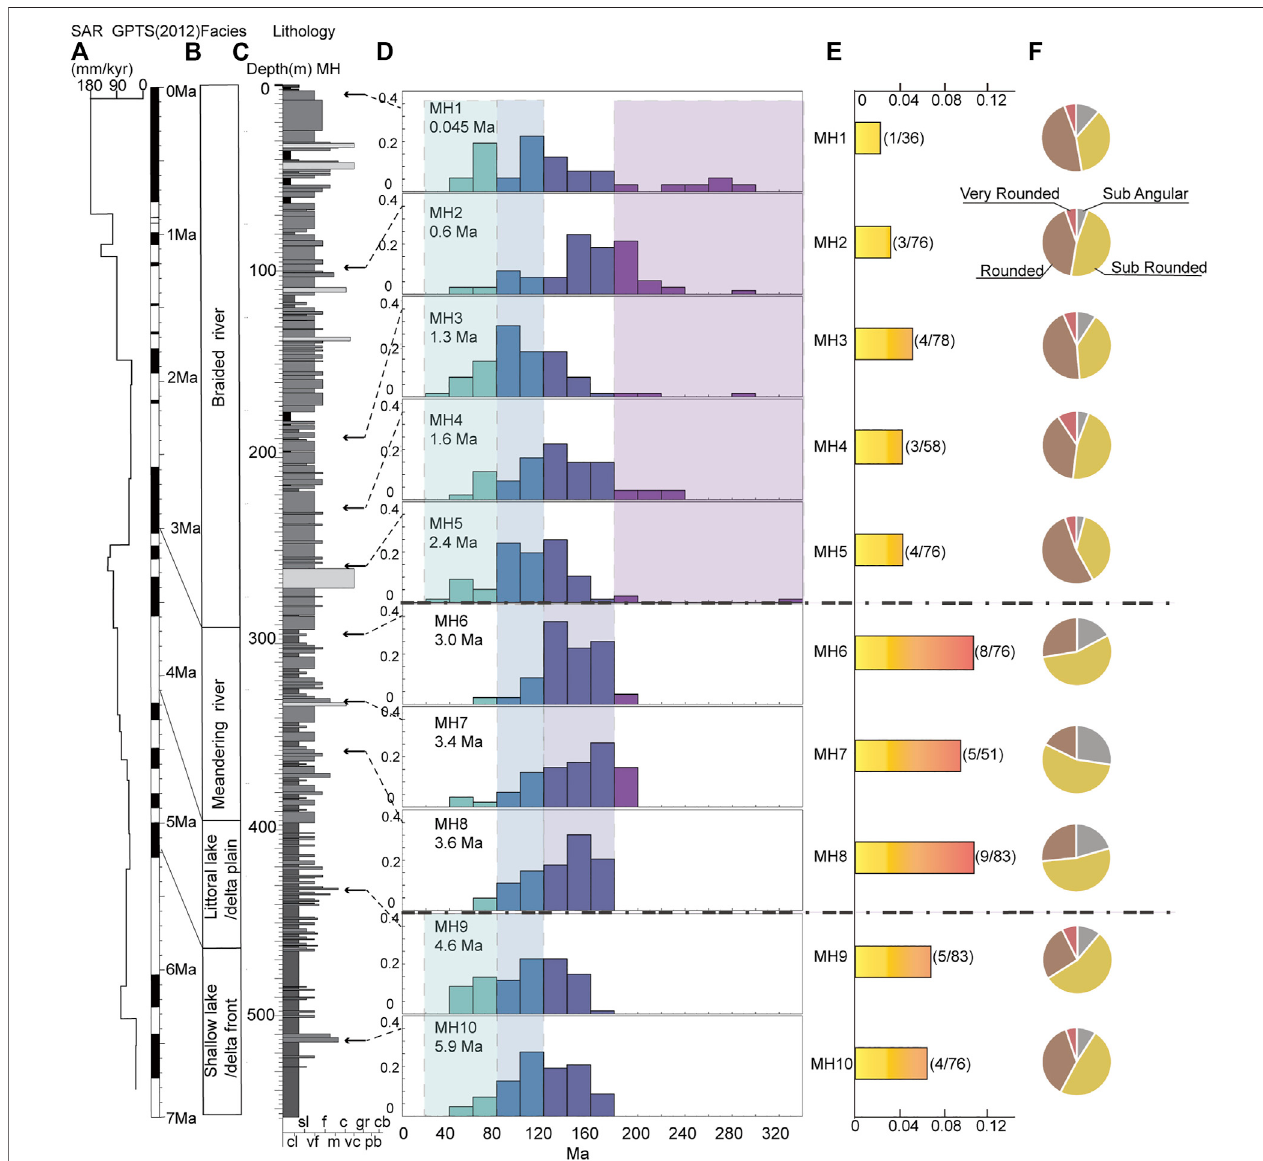
FIGURE 3 | (A) Comparison of the sediment accumulation rate (SAR). (B) Sedimentary facies. (C) Lithology: cl — clay; sl — silt; vf — very fi ne sand; f — fi ne sand; m — mediumsand;c — coarsesand;vc — verycoarsesand;gr — granule;pb — pebble;cb — cobble(Huetal.,2019a). (D) Thesinglegrainagedistribution. (E) Thecontent of euhedral apatite particles (euhedral apatite particles/all observed apatite particles). (F) The roundness of apatite